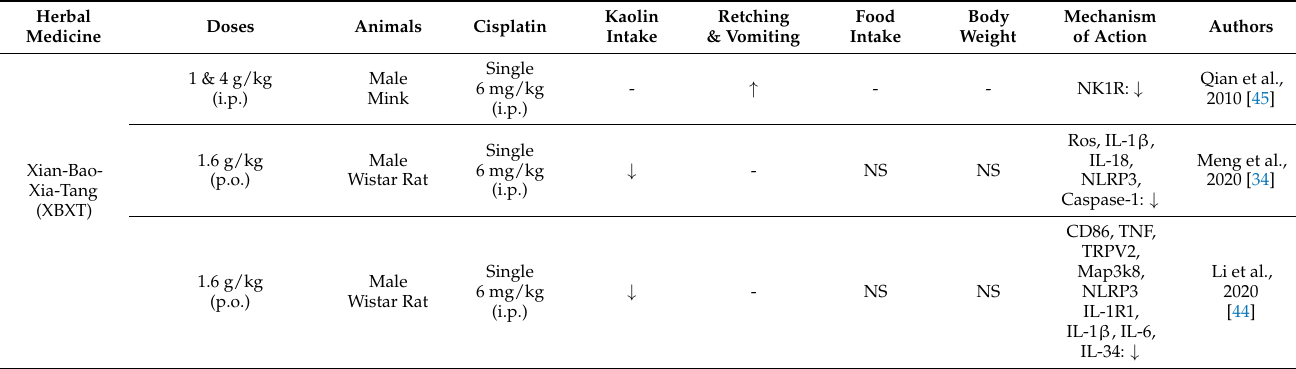
Table 1. Summary of Studies on Cisplatin Induced-Nausea &